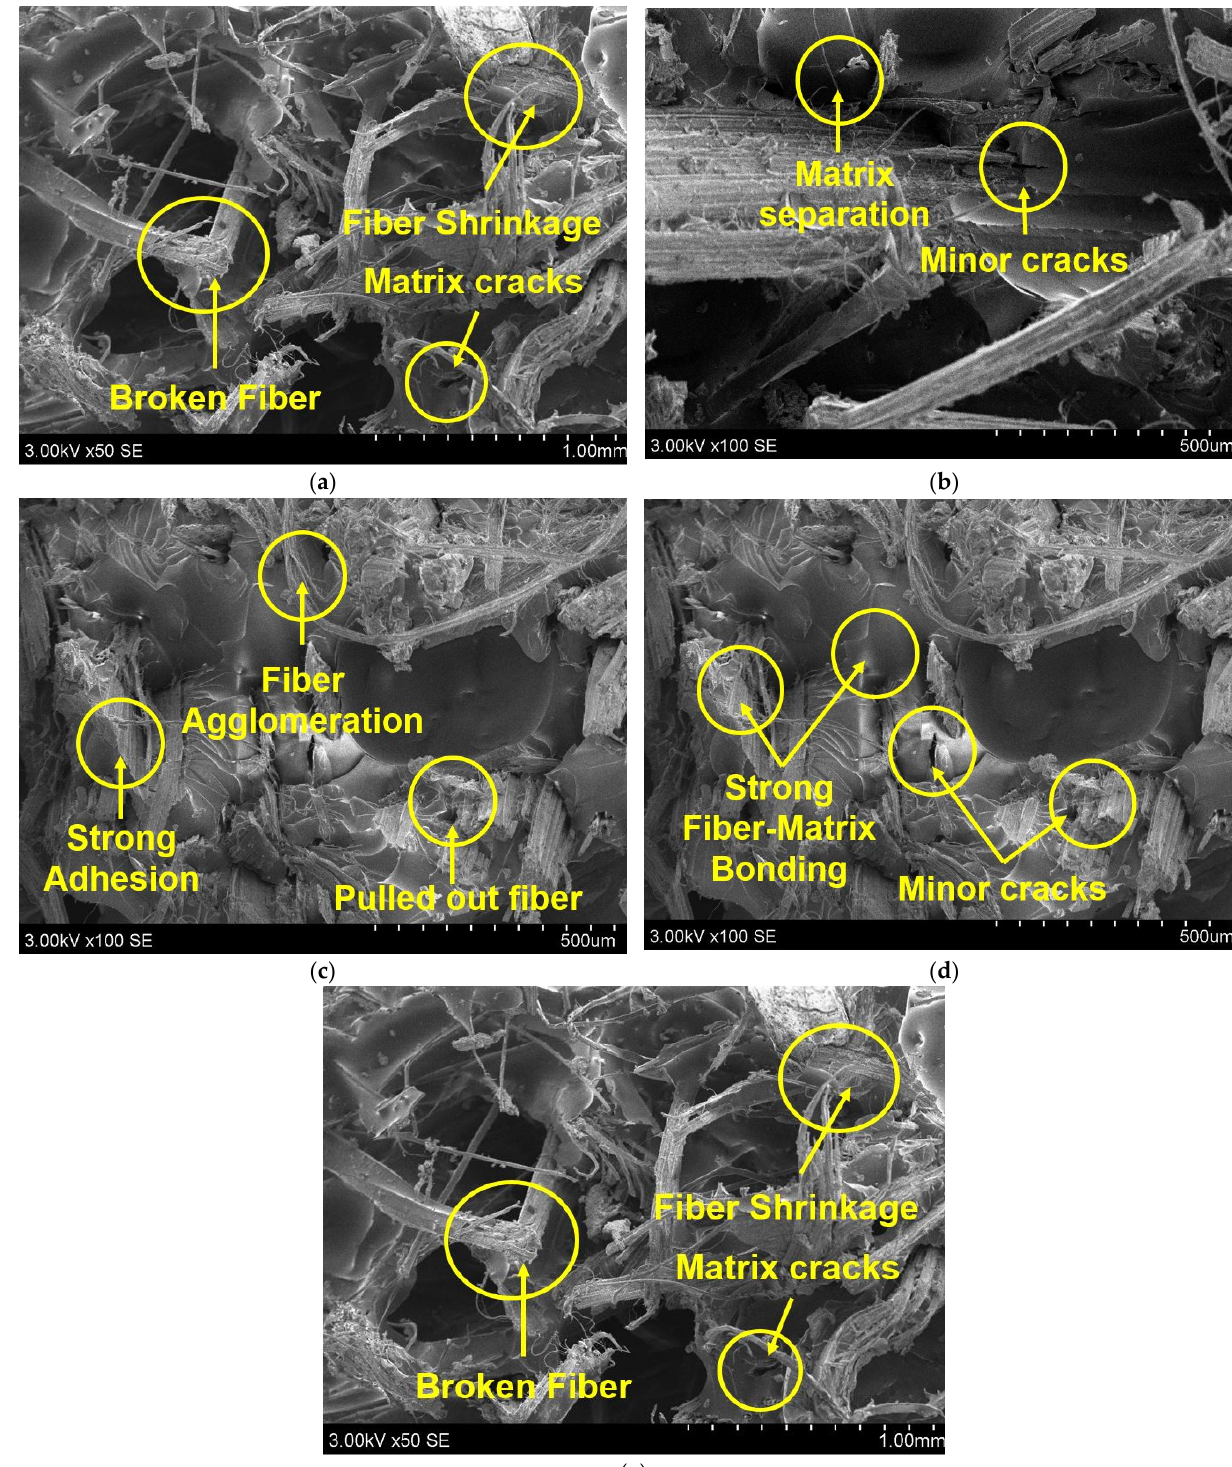
Figure 3. SEM analysis of flexural tested hemp- and flax-fiber-reinforced epoxy matrix composites. ( a ) 40H/0F, ( b ) 15H/25F, ( c ) 20H/20F, ( d ) 25H/15F, and ( e ) 0H/40F.